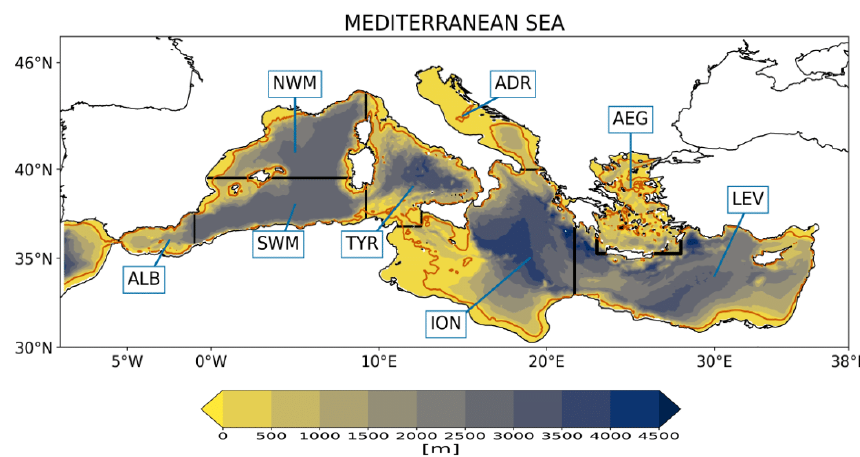
Figure 1. Mediterranean Sea bathymetry (in m) and relative sub-basins considered in the analysis: the Alboran Sea (ALB), North Western Mediterranean (NWM), South Western Mediterranean (SWM), Tyrrhenian (TYR), Adriatic Sea (ADR), Ionian Sea (ION), Aegean Sea (AEG) and Levantine Basin (LEV). The dark orange line marks the 200m isobath in the model domain. The domain boundary is set at longitude 8.8 ◦ W, westward of the Strait of